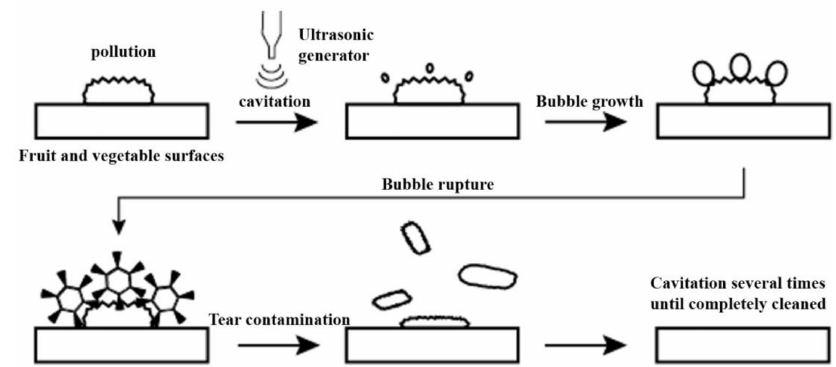
Figure 1. Ultrasonic cleaning